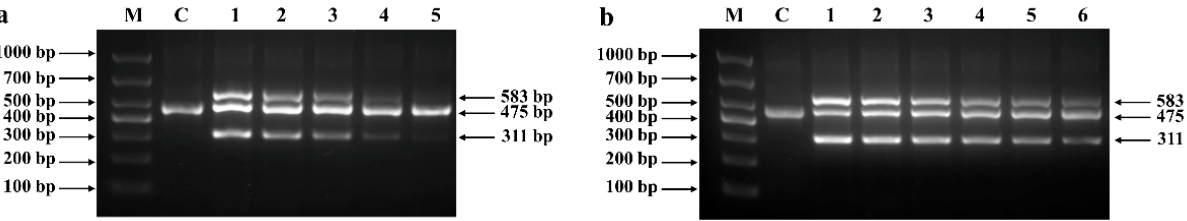
Figure 5. Evaluation of the detection limit of pathogenic Listeria spp. in lettuce sample. ( a ) mPCR assay without PEI-MNPs magnetic enrichment. Lane M: DL1000 DNA Marker; lane C: negative control; lanes 1 to 5: 10 6 CFU/mL to 10 2 CFU/mL of Listeria . ( b ) PEI-MNPs magnetic enrichment combined with mPCR assay, Lane M: DL1000 DNA Marker; lane C: negative control; lanes 1 to 6: 10 6 CFU/mL to 10 1 CFU/mL of Listeria . The bands at 583 bp, 311 bp, and 475 bp represented L. monocytogenes , L. ivanovii , and IAC, respectively.